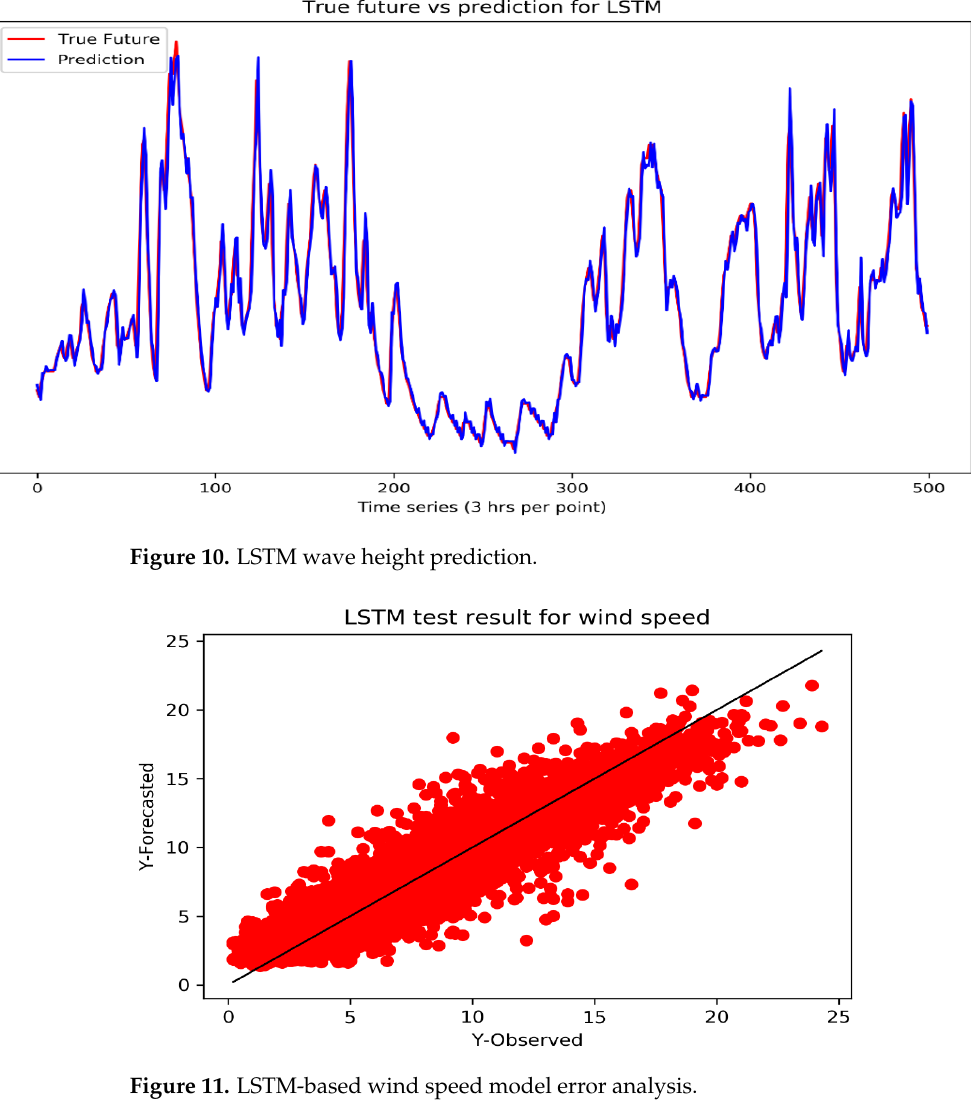
Figure 9. LSTM wind speed prediction.